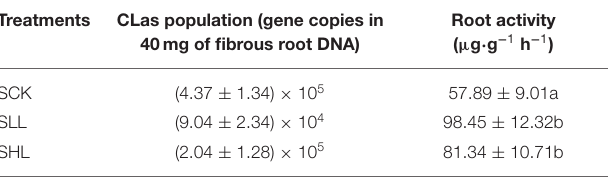
TABLE 2 | Changes in CLas population and root activity of HLB-infected citrus with low slaked lime (SLL) and high slaked lime (SHL) applied to the soil surface. Treatments CLas population (gene copies in 40mg of fibrous root